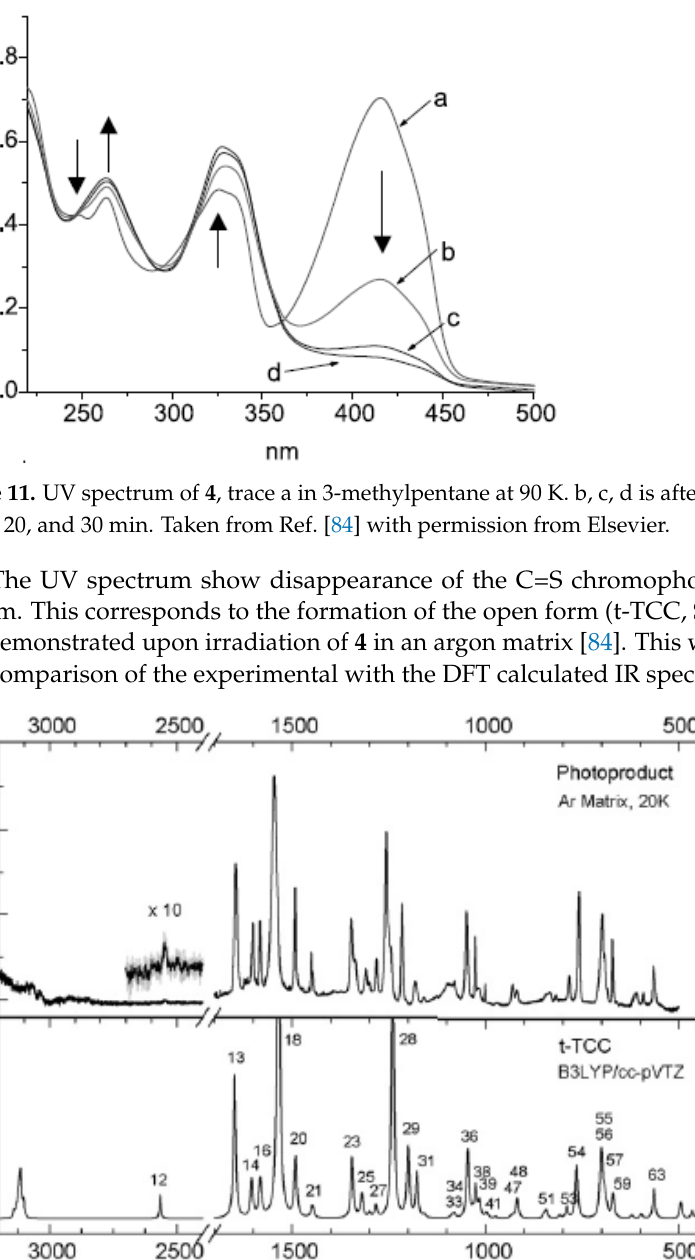
Figure 12. Top: Infrared spectrum of open form (t-TCC) obtained after irradiation of 4 in an argon matrix at 20 K. Bottom: Calculated DFT spectrum (B3LYP/cc-pVTZ). Taken from Ref. [85] with permission from Elsevier.